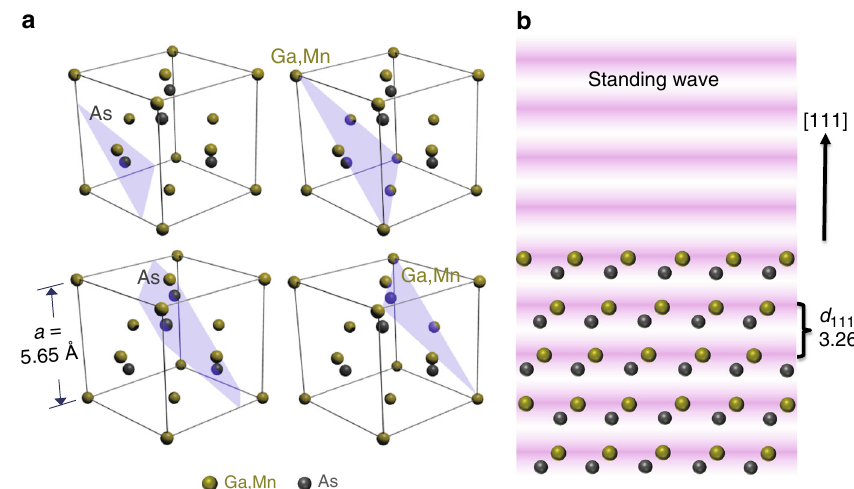
Fig. 1 Schematics of the experiment. a The unit cell of undoped GaAs with four different (111) planar cuts intersecting different sites of its zinc blende structure. A {111}-type re fl ection, actually (-1-1-1), was chosen because the Ga(Mn) and As atoms do not lie together on these planes, with the type of atom intersected by each plane indicated in the fi gure. b A schematic side view of the experimental geometry, where the oscillations of the excitation fi eld along the [111] direction are depicted and different atomic species are excited with a different intensity of primary radiation depending on the position of the nodes and antinodes of the standing